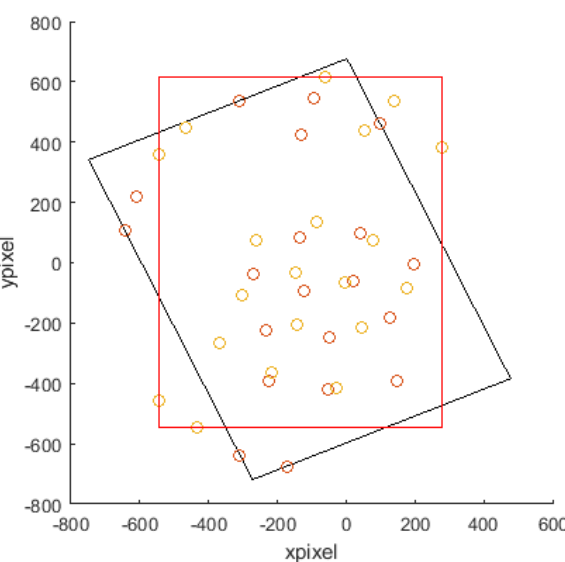
Figure 23. Feature vector mapping using Kernel Principal Component